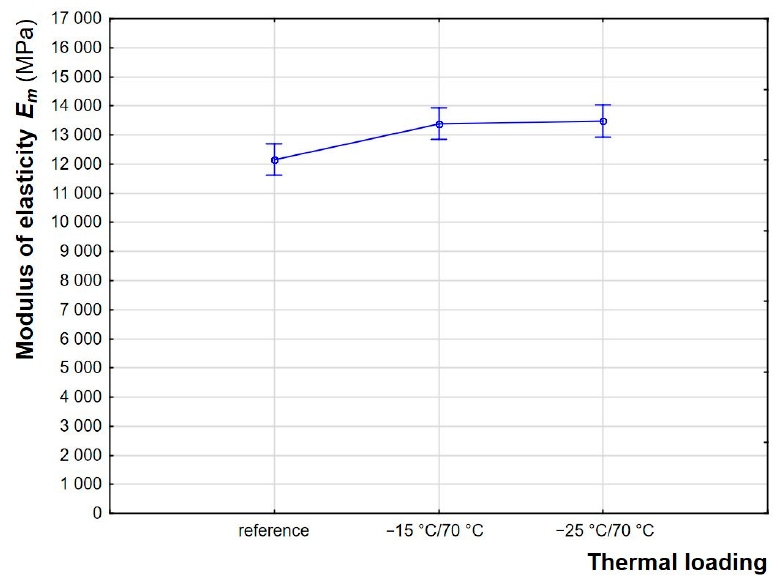
Figure 5. The effect of thermal loading on the modulus of